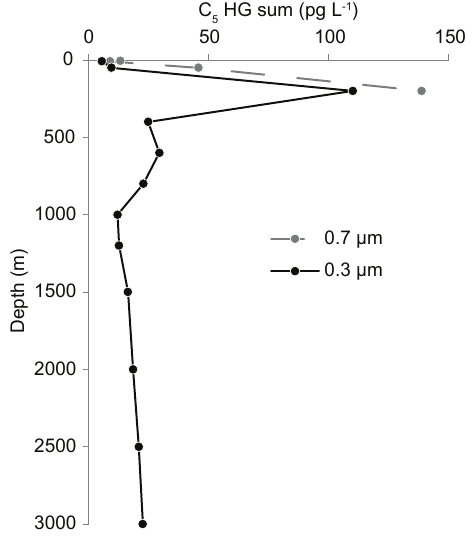
Figure 5. Station 10: down column profile of C 5 HG sum (C 5 HG 30 triol + C 5 HG 32 triol, pgL − 1 ) from 0.7µm GF/F filters (grey dashed line) and 0.3µm GF75 filters (solid black